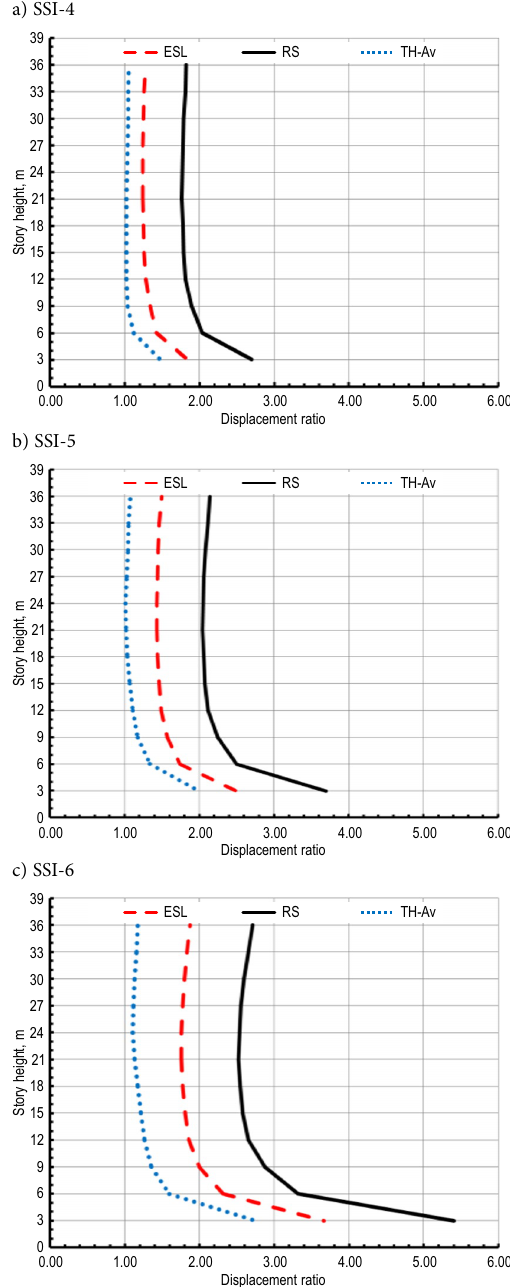
Fig. 11. Story lateral displacement of SSI model to that of NSSI model of 12-story